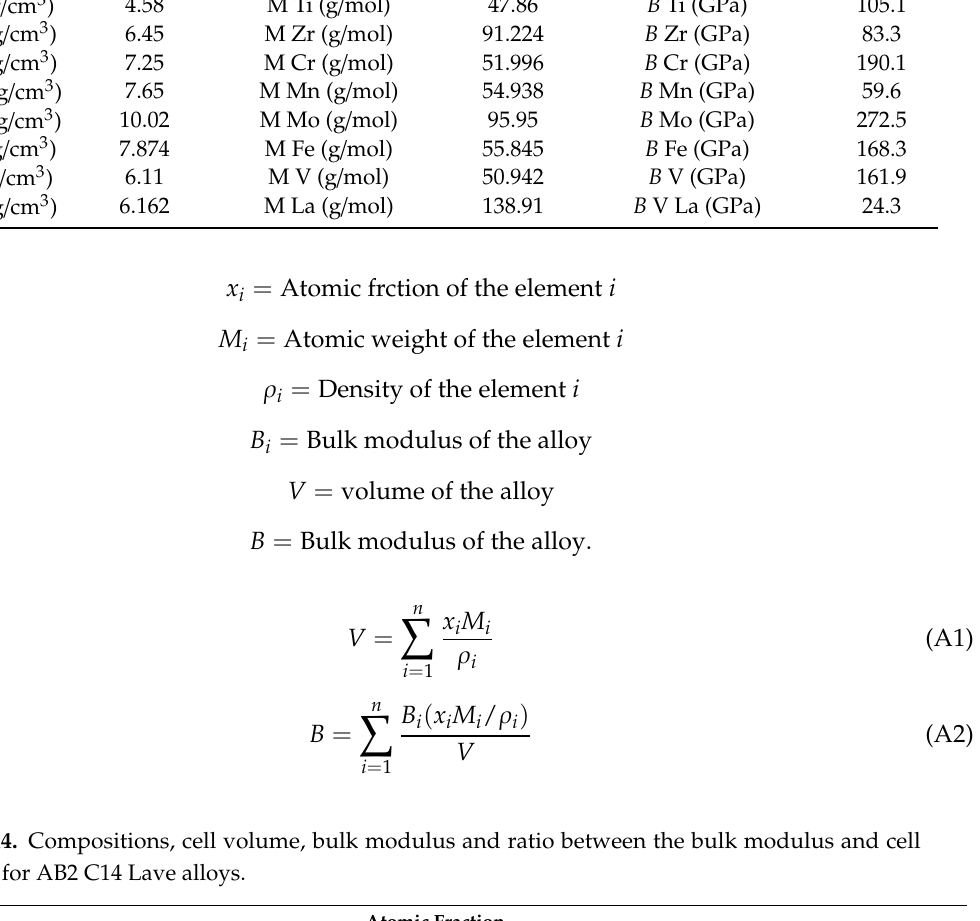
Table A3. Properties of the elements for the calculation of the bulk modulus of alloys. Density [71]